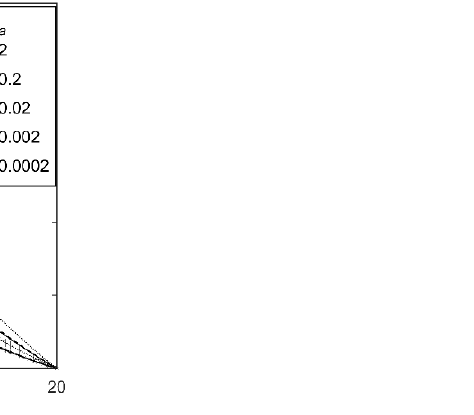
Figure 5. The MTF( f ) as a function of the carrier lifetime in the blocking layer of a-Se mammographic detectors.